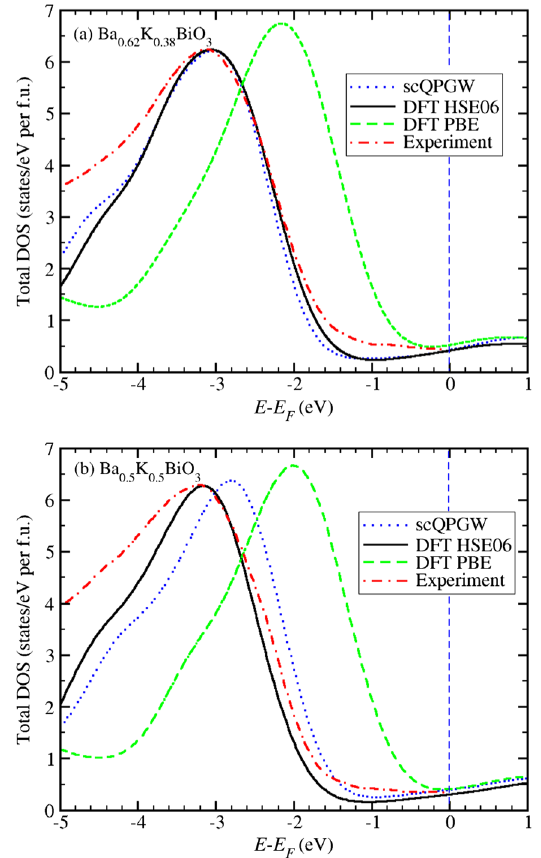
FIG. 2. Densities of states of Ba K BiO . (a) The DOS of Ba Ba 0 : 5 0 : 5 3 the PBEfunctional, the HSE06 screened hybrid functional, and the self-consistent quasiparticle GW , where doping is approximated with the rigid band approximation. (b) The DOS of Ba calculated using the PBE functional, the HSE06 screened hybrid functional, and the self-consistent quasiparticle GW . Here, the doping is simulated with a 2 (cid:5) 2 (cid:5) 2 supercell by substituting half of the Ba atoms with K atoms. The experimental data are the ultraviolet photoemission spectra for (a) Ba (b)